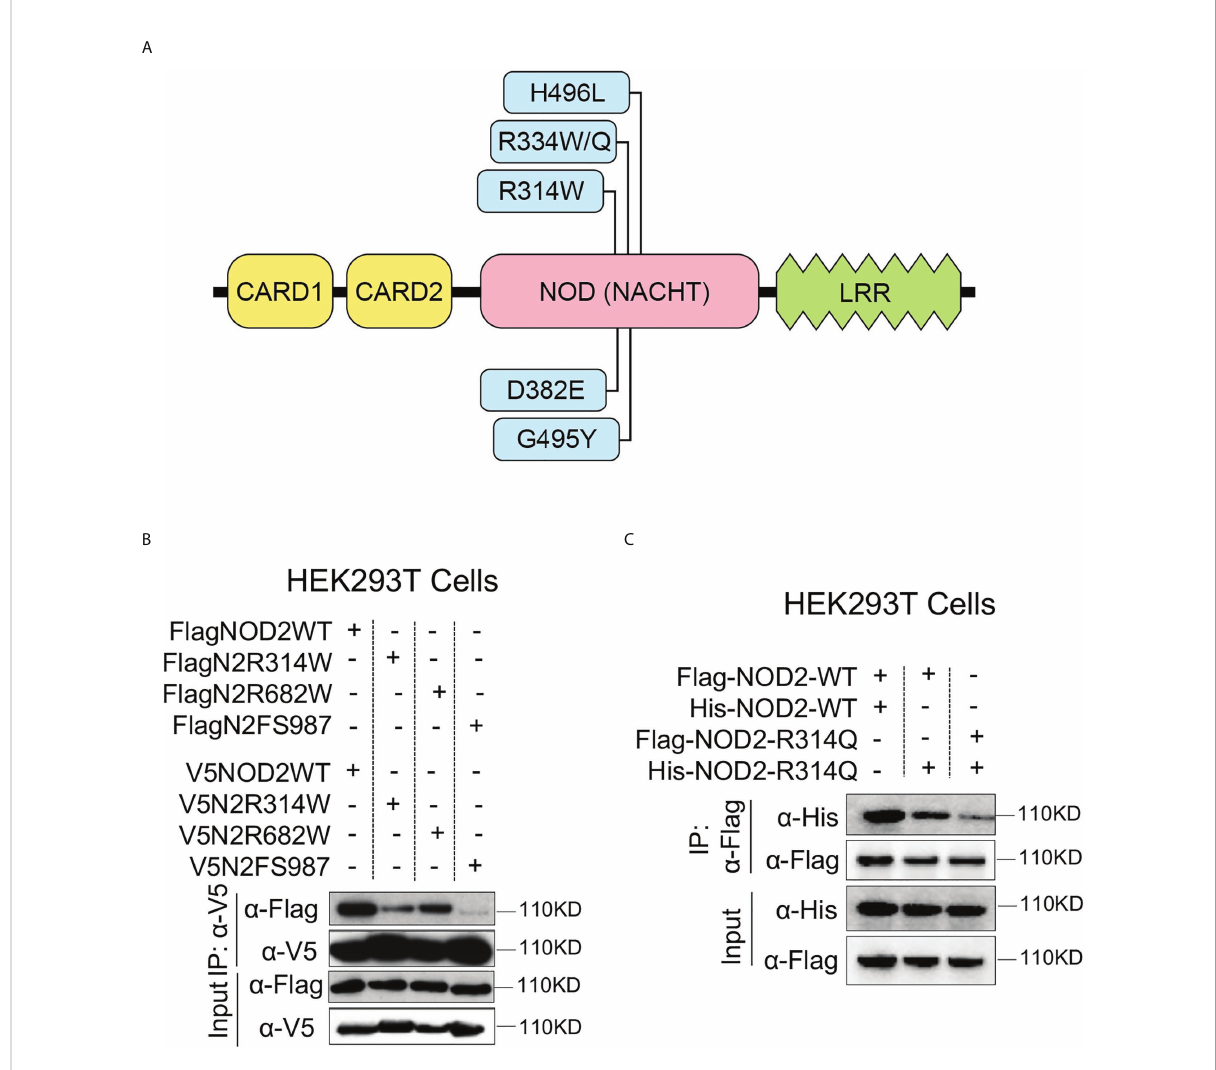
FIGURE 1 The BS-NOD2 Mutation Causes Reduced NOD2 Self-Interaction. (A) Diagram of NOD2 structure showing main NOD2 domains and locations of nucleotide binding domain Blau mutations in the Blau constructs studied here. (B) HEK293T cells were transfected with constructs expressing Flag- or V5-tagged mouse wildtype NOD2 or Blau syndrome-associated mutations (FlagN2R314W, FlagN2R682W) or NOD2 with